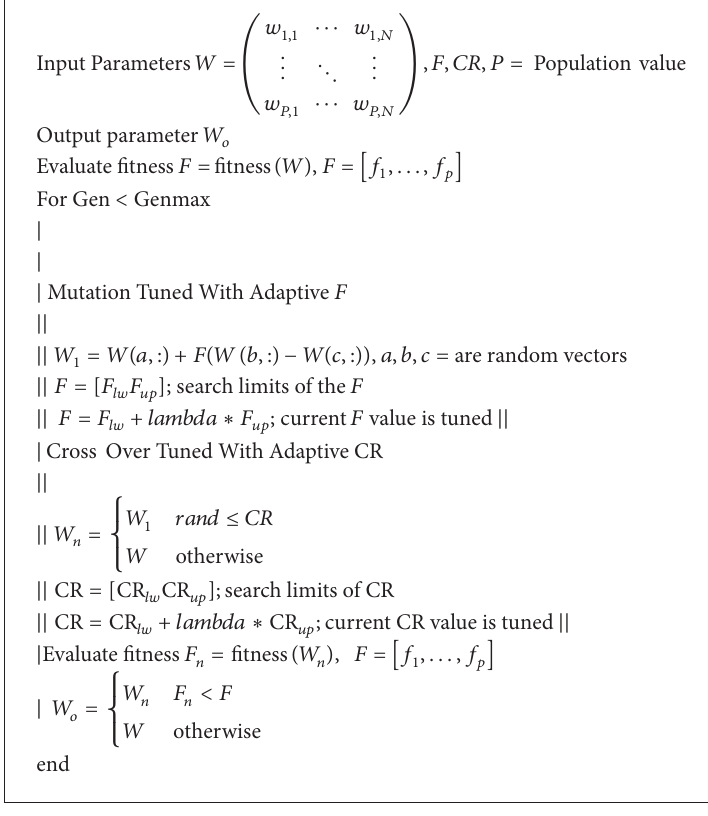
Pseudocode 1: Pseudocode of Adaptive DE